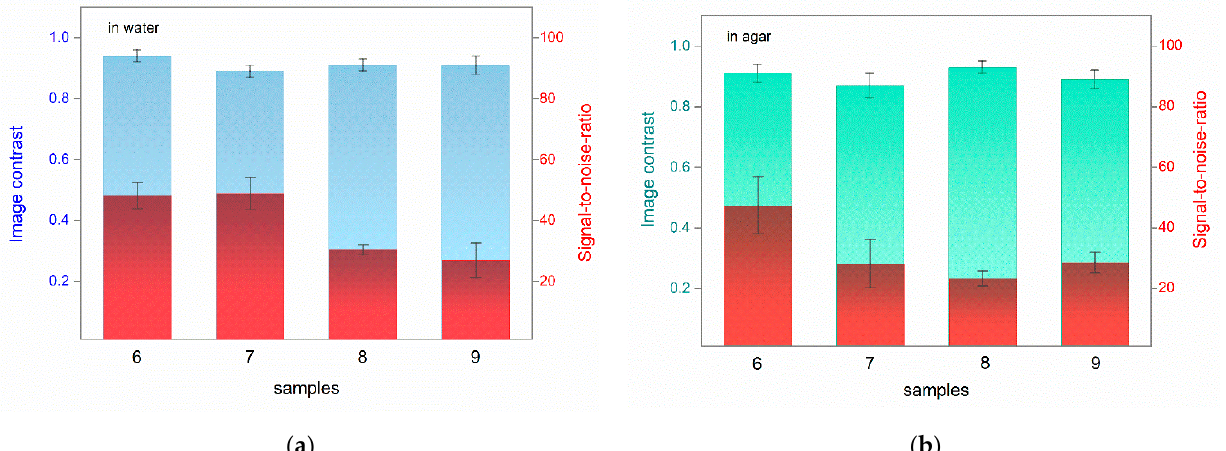
Figure 5. Comparison of CI and SNR values in PA images of all samples acquired in: ( a ) water; ( b ) agar. The left axis reports CI values (blue for water and green for agar), and the right axis reports SNR values (red for both water and agar).